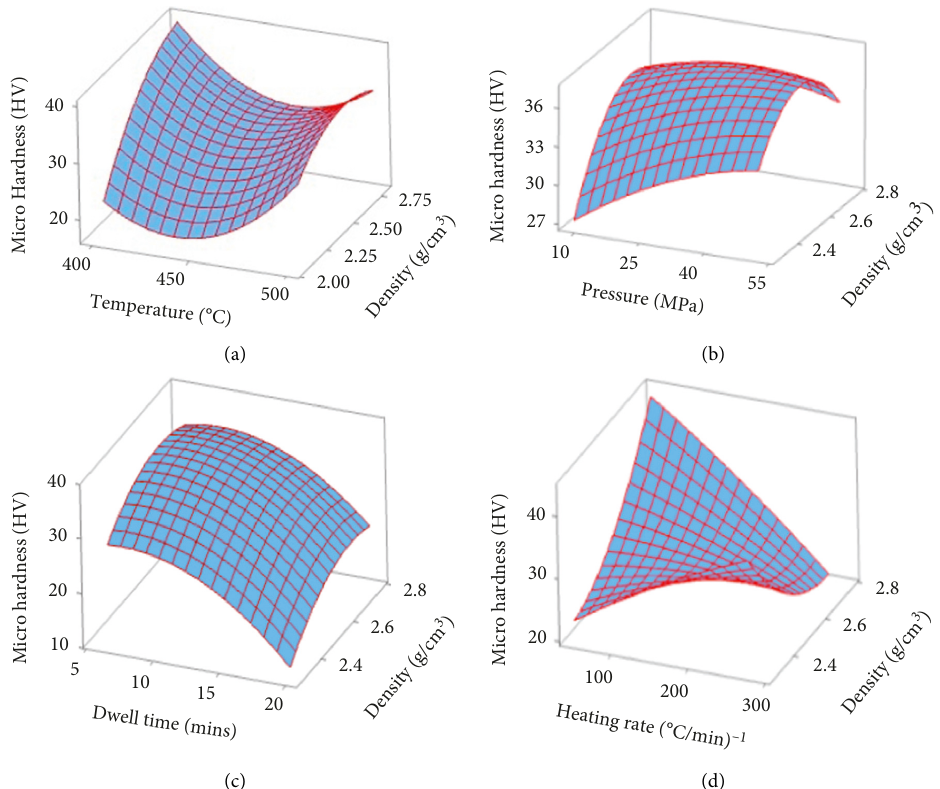
Figure 3: Impact of processing factors on the density and microhardness of AA2219-2%WC-2% silicon nitride: (a) temperature, (b) pressure, (c) dwell time, and (d) heating rate.